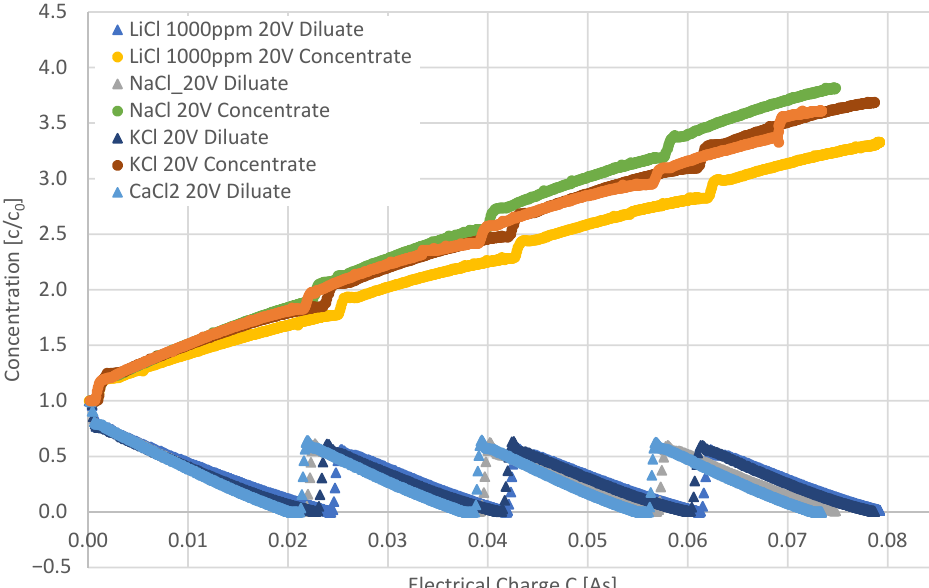
Figure 8. Comparison of investigations with LiCl, NaCl, KCl, and CaCl 2 as a function of the electrical charge with adjusted values (c/c0) at ϑ = 21 °C.